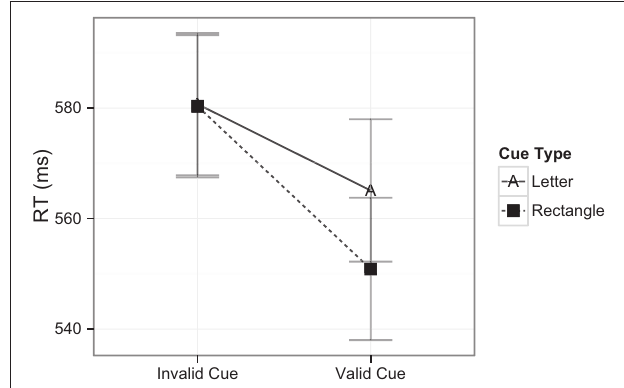
FIGURE 10 | Mean accuracy rates across tasks and cue types.